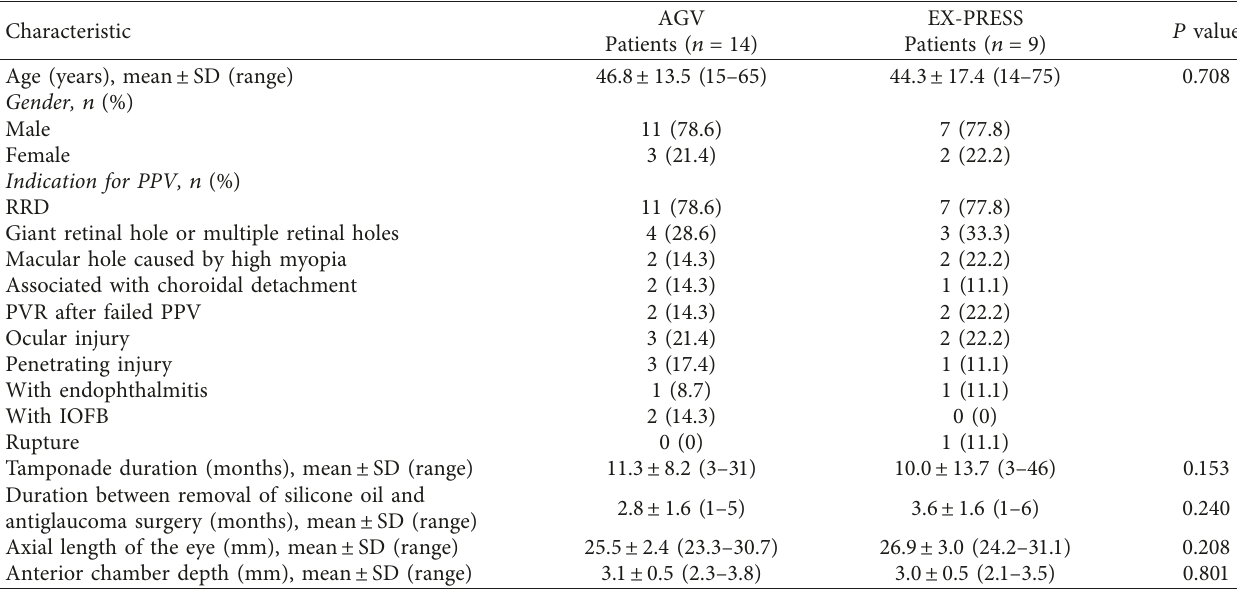
Table 1: Baseline characteristics of the study